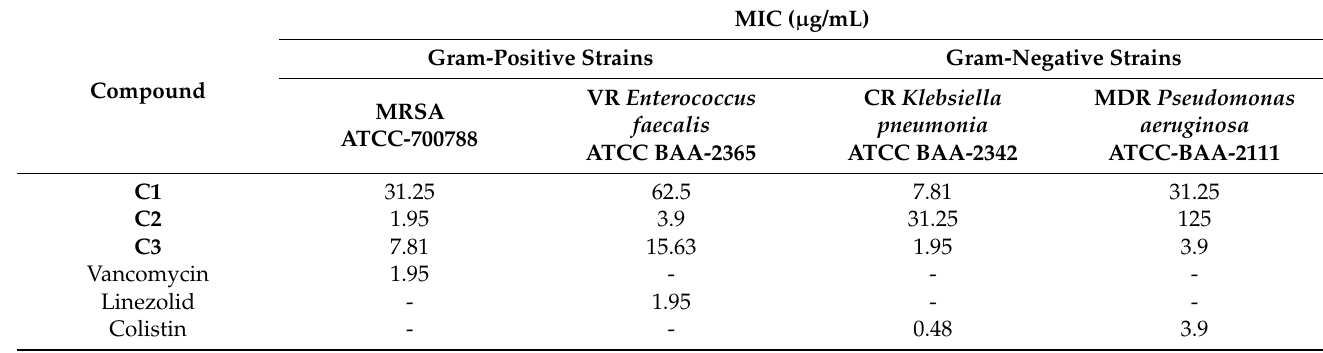
Table 3. MIC ( µ g/mL) of the isolated compounds against resistant bacterial